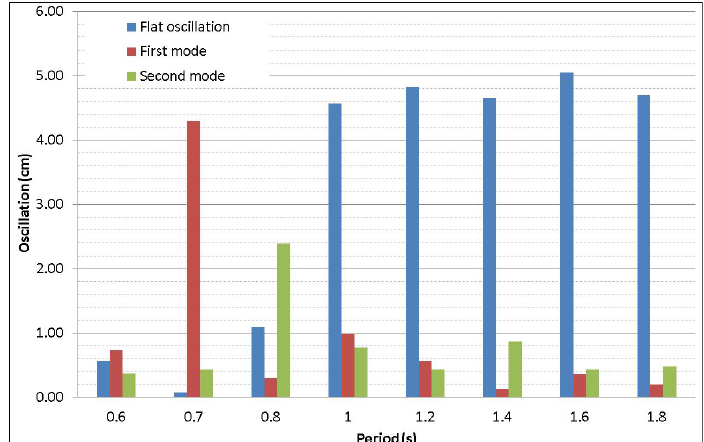
Figure 11. Height of the oscillation within the first chamber, for regular wave tests with H = 6 cm and varying